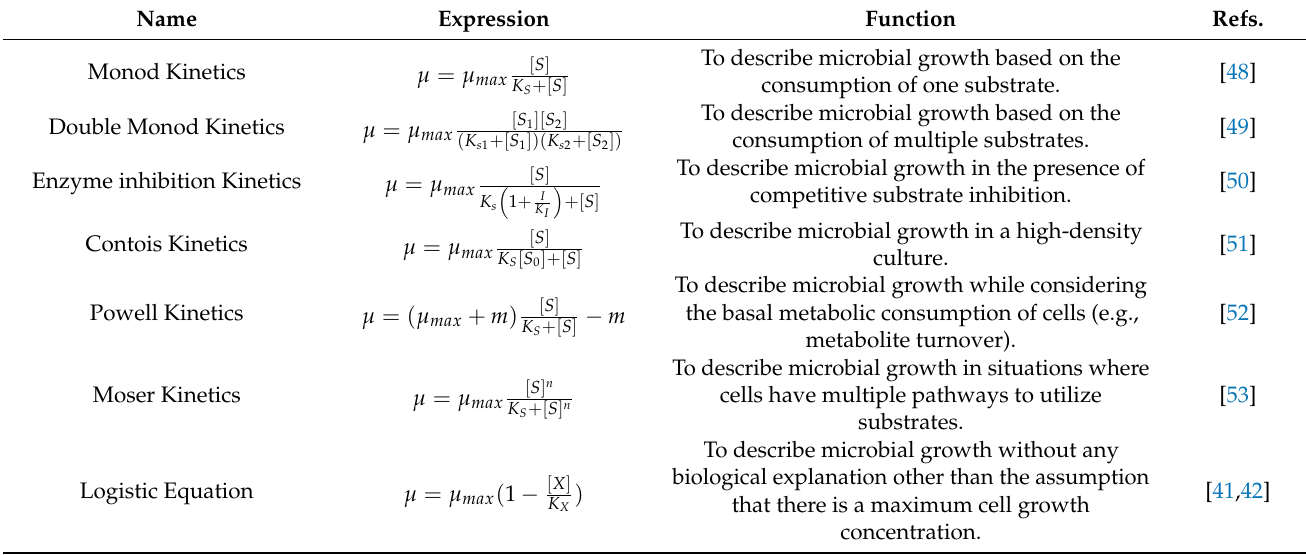
Table 1. General macroscopic kinetic